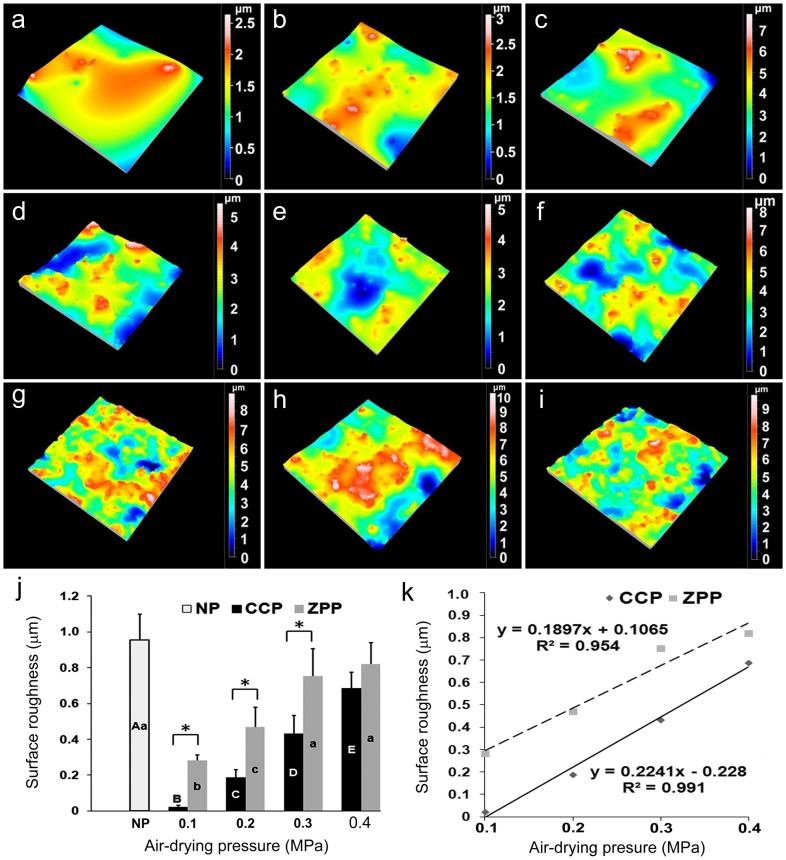
Surface roughness of specimens in subgroups.(a–h) 3D surface images (350 µm×350 µm) of specimens obtained from optical profilometry in subgroups: (a) CCP-0.1 MPa; (b) CCP-0.2 MPa; (c) CCP-0.3 MPa; (d) CCP-0.4 MPa; (e) ZPP-0.1 MPa; (f) ZPP-0.2 MPa; (g) ZPP-0.3 MPa; (h) ZPP-0.4 MPa; (i) NP. (air blasted zirconia without primer application) (j) Mean roughness (Sa) of experimental subgroups and control NP in µm. Data are presented as means and standard deviations (n = 6). For CCP subgroups, the same upper case letters represent absence of statistically significant difference (p>0.05). For ZPP subgroups, the same lower case letters represent absence of s statistically significant difference (p>0.05). Asterisks indicate significant differences between the two ceramic primers (p<0.05). (k) Correlations between surface roughness and air-drying pressure in the CPP and ZPP ceramic primers.